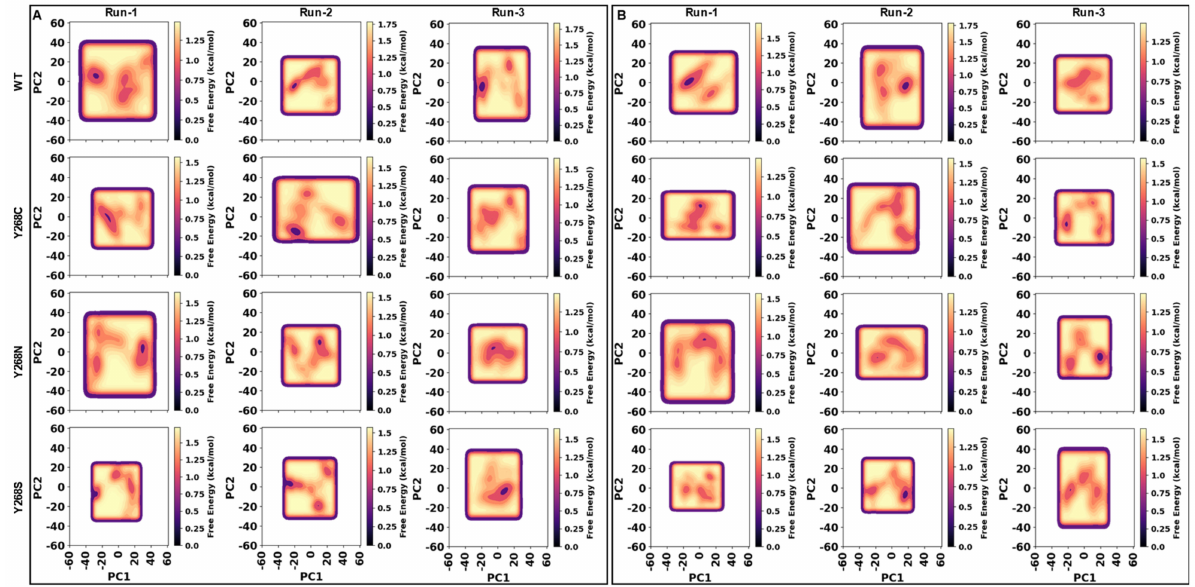
Figure 7. Principal component analysis (PCA) of the holo and ATQ bound proteins. ( A ) Holo; ( B ) ATQ bound protein. The plots show a 3-dimensional (3D) plot of PC1 versus PC2 of the WT and mutant holo proteins as a function of free energy. All protein systems were shown in three replicate runs (Run-1, Run-2 and Run-3). Each scale corresponds to each individual plot where the black color at 0 kcal/mol represents lowest free energy